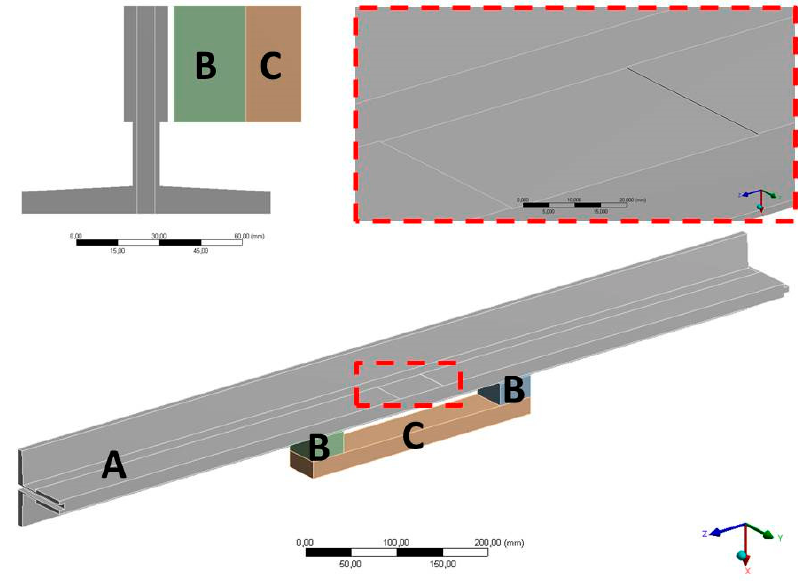
Figure 3. Model subject to numerical analysis.